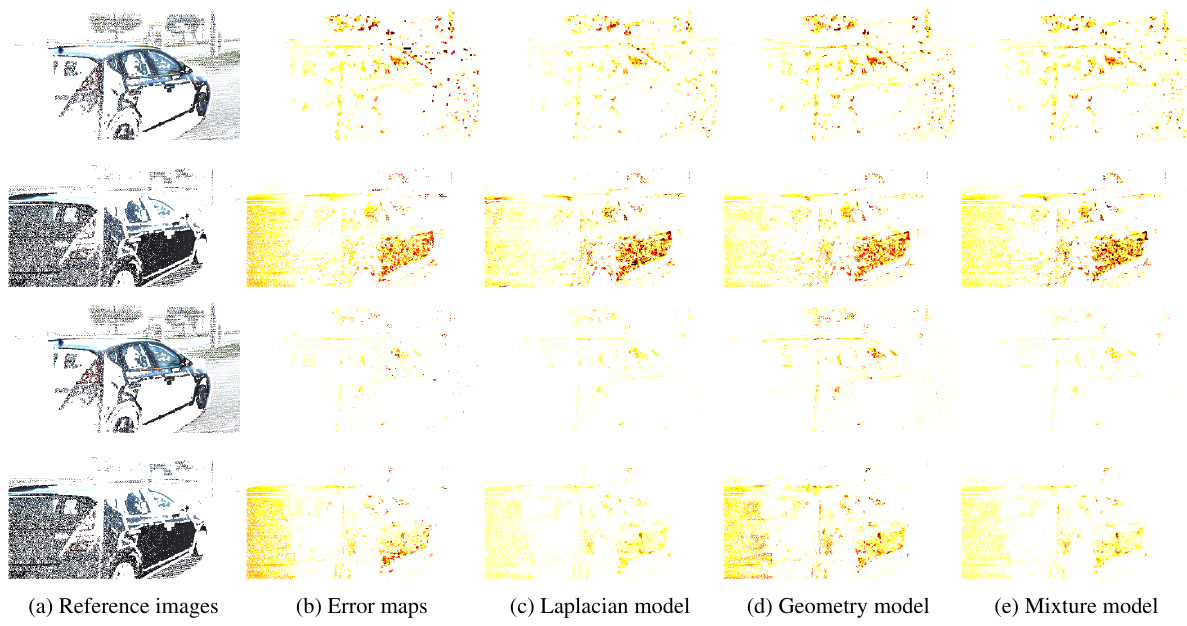
Figure 5. Qualitative uncertainty evaluation on the KITTI 2015 dataset. From top to bottom, the “good” and the “hard” regions based on Census-BM and MC-CNN disparity methods are shown. For details on the colour coding, please refer to Fig. 4. The uncertainty maps based on Census-BM generated by the two proposed models are smoother at the texture-less rear of the car, while the Laplacian model generates noisy uncertainties in this